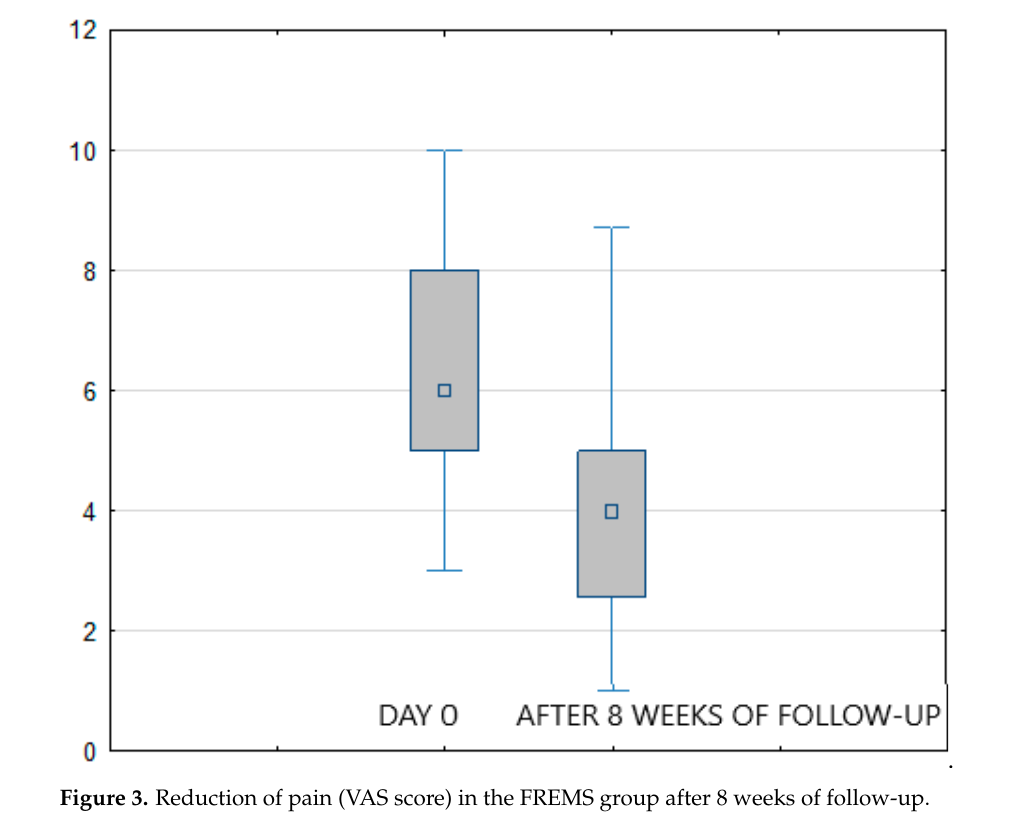
Figure 3. Reduction of pain (VAS score) in the FREMS group after 8 weeks of follow-up.